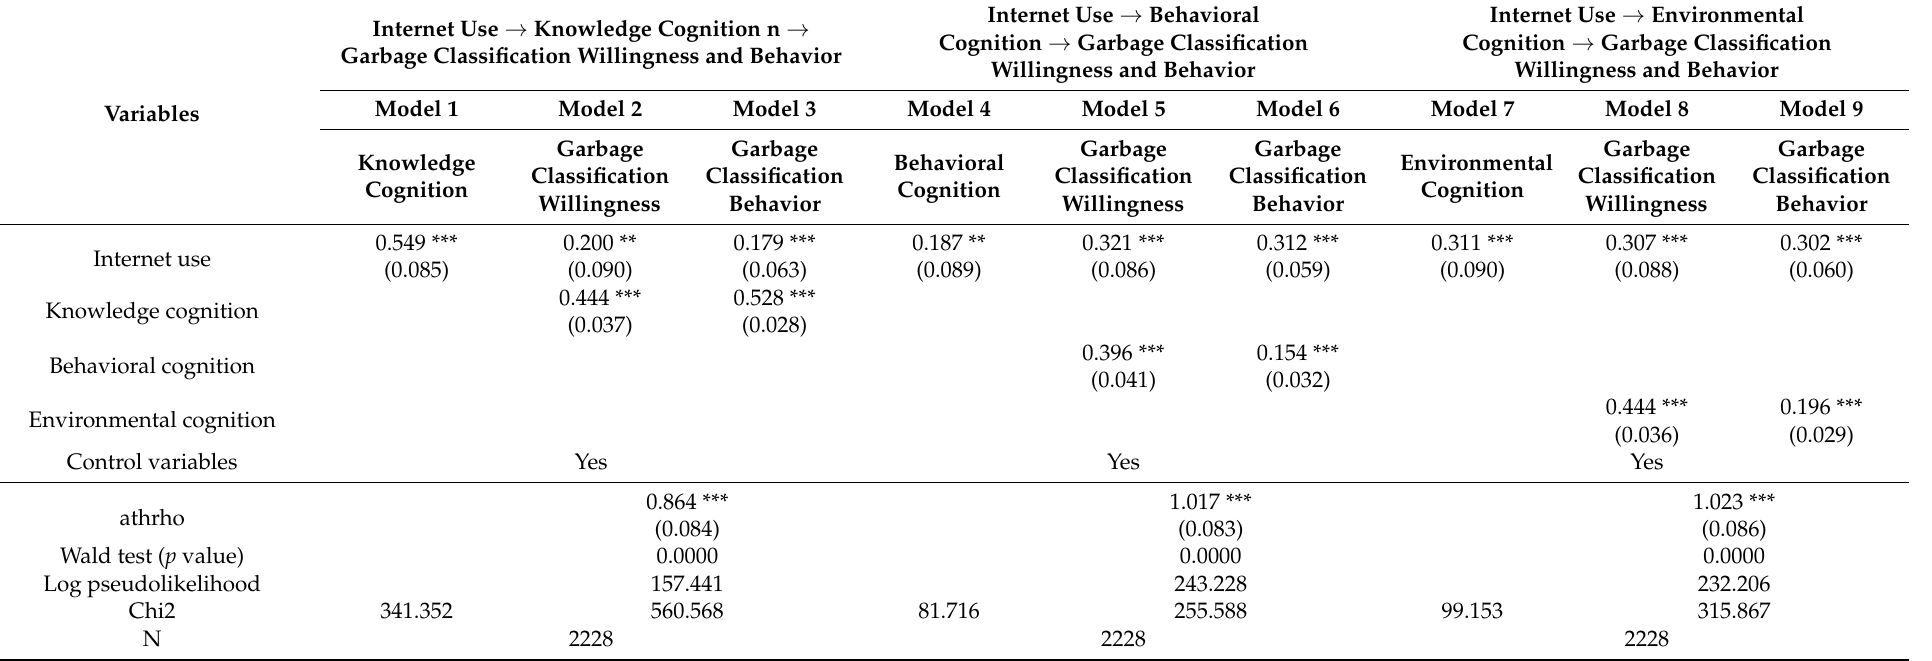
Table 7. Analysis of the mediating effect of garbage classification willingness and